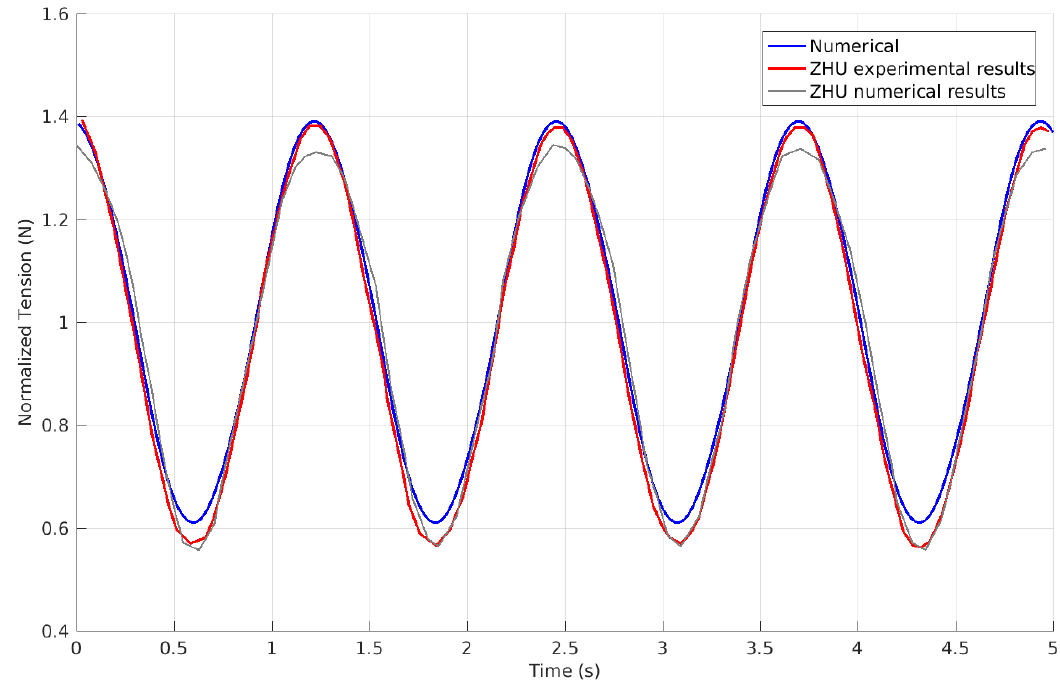
Figure 4. Optimal validation with Zhu’s low-frequency experiment